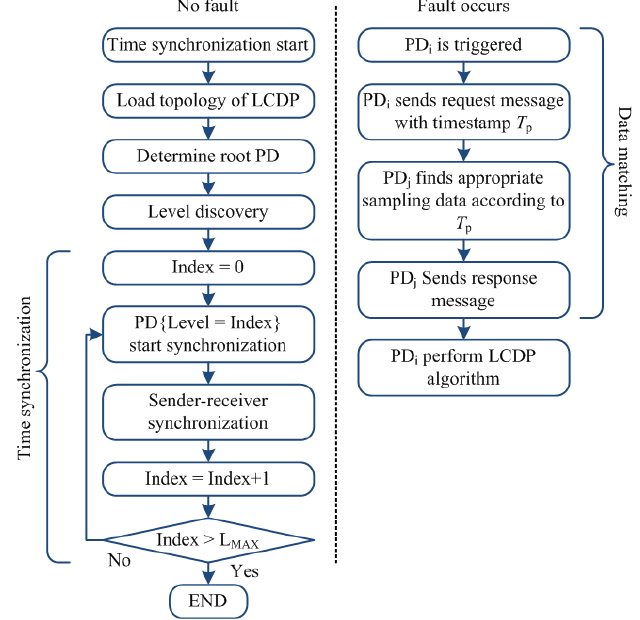
Figure 3. The flow chart of data synchronization method for line current di ff erential protection (LCDP) algorithm.